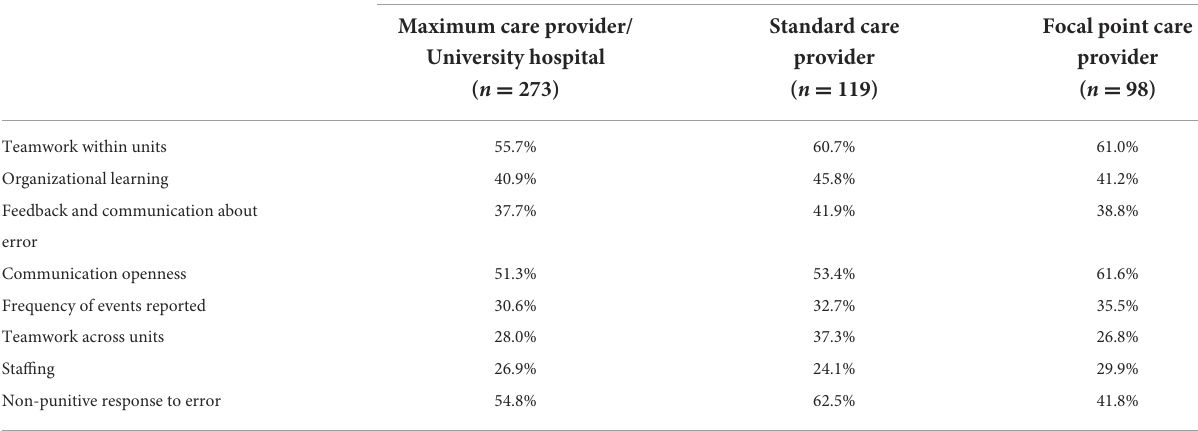
TABLE 3 Composite percent positive responses of HSOPSC dimensions divided by hospital type.